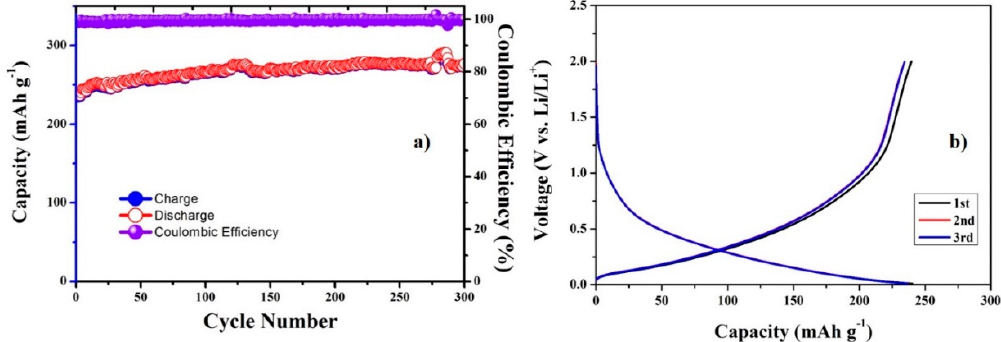
Figure 8. ( a ) Cyclic performance and ( b ) initial voltage profiles of the pyrolyzed CNC electrode at 100 mA g − 1 . The pyrolysis temperature is 800 °C.